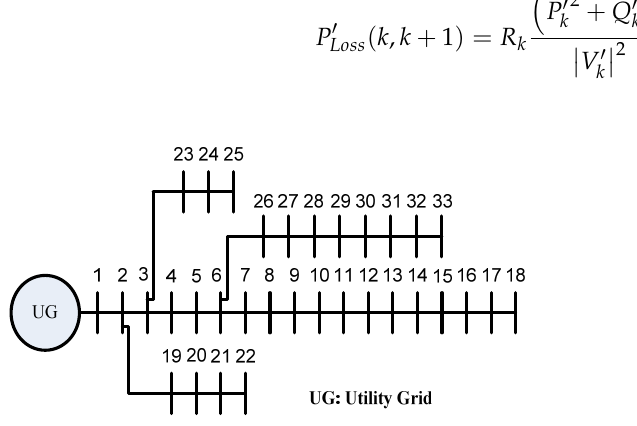
Figure 2. Schematic of IEEE-33 bus test system.